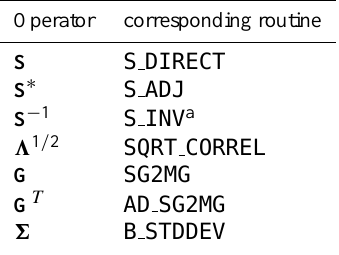
Table A1. List of operators and matrix operations that define L and L ∗ , and the routines in which they are coded. Operator corresponding